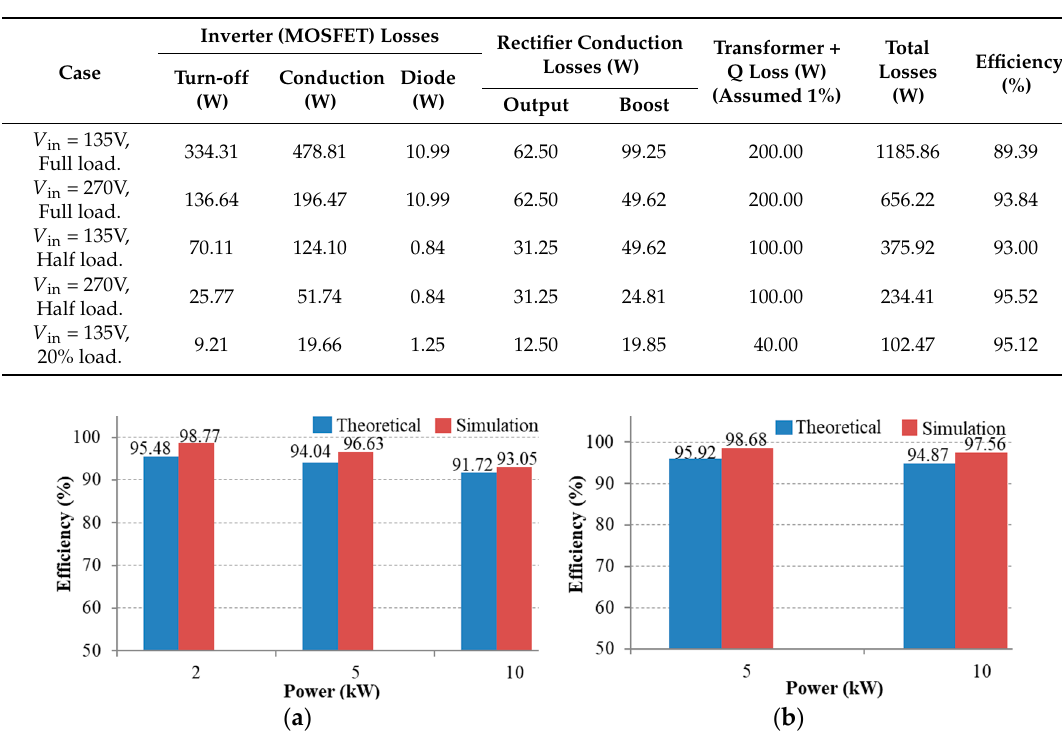
98 o . ( a )–( b ) Figure 7 waveforms repeated.